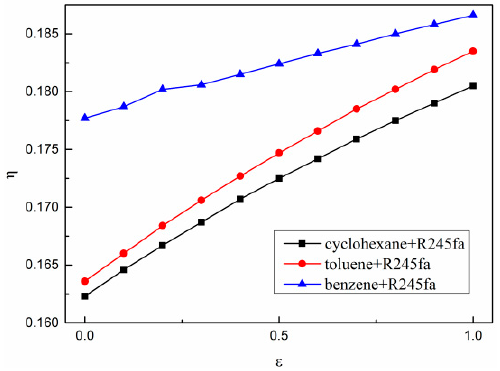
Figure 7. The effect of regenerator efficiency on the thermal efficiency of the cycle.